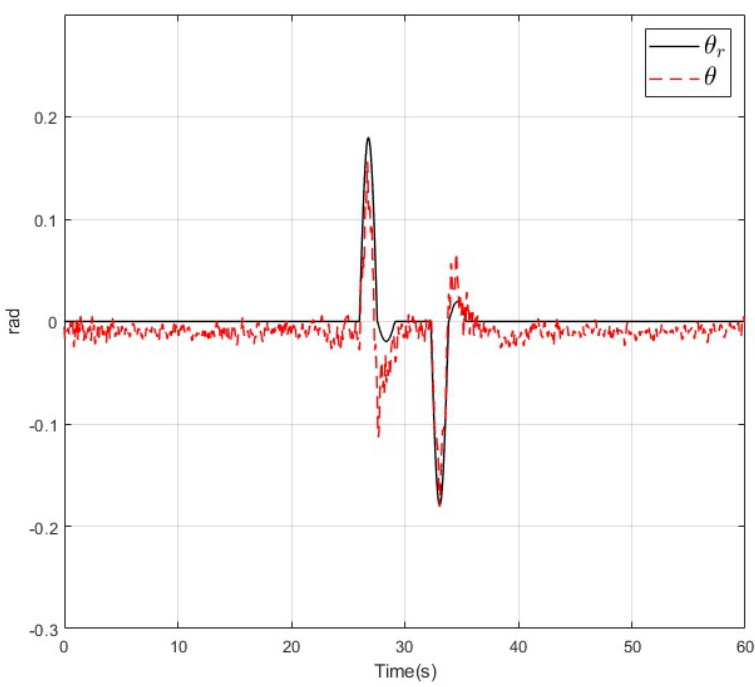
Figure 15. Pitch angle (dashed) and its reference (solid) during the real-time